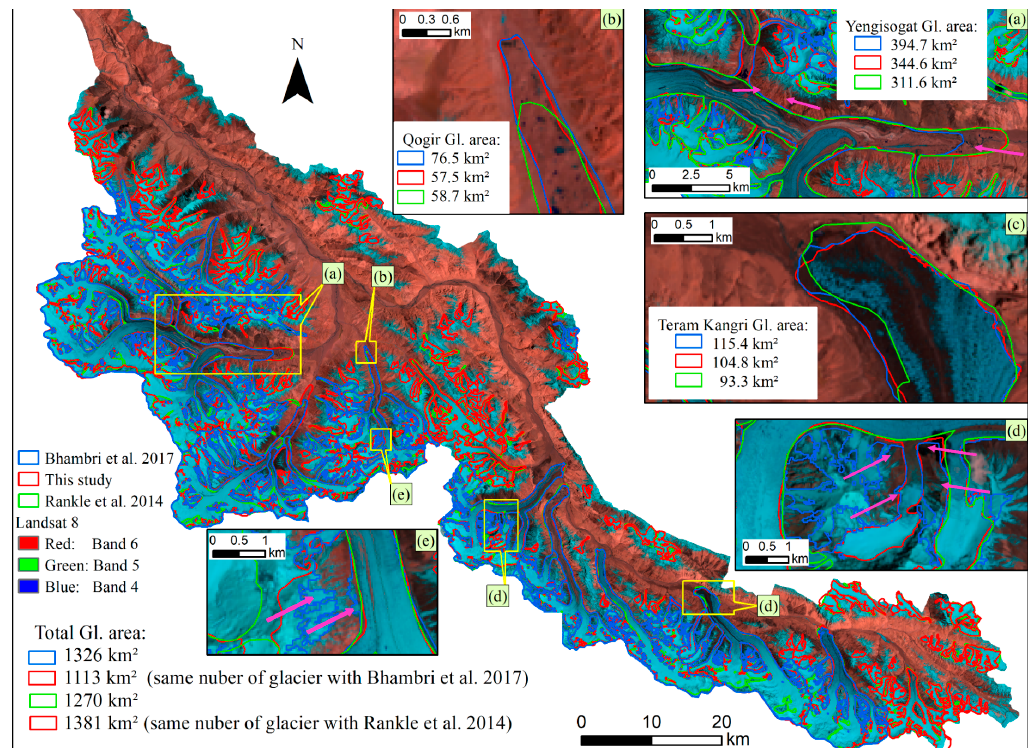
Figure 16. Comparisons of glacier outlines and glacier area based on this study, Rankl et al. study and Bhambri et al. study .